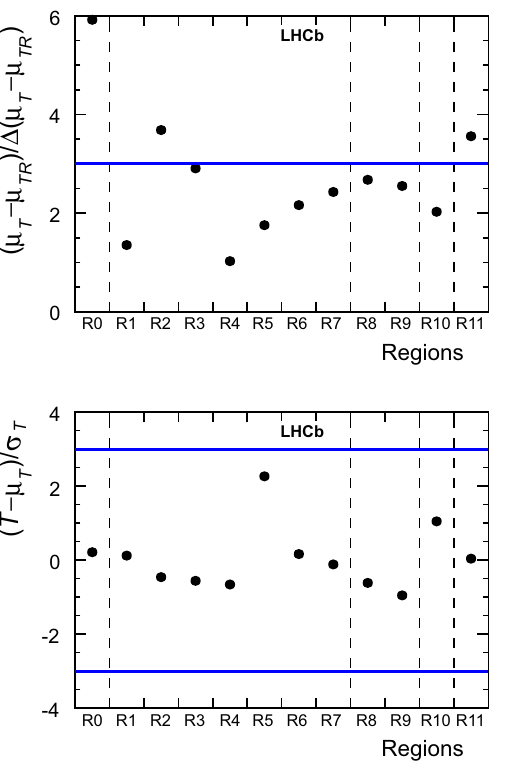
lines in the left figures represent − 3 and + 3 pull values. R0 corresponds to full Dalitz plot and R2 is separated into R8 and R9, R10 is separated into R4 and R5, R11 is separated into R4, R5, R6 and R7, and these regions are correlated and separated by dashed lines